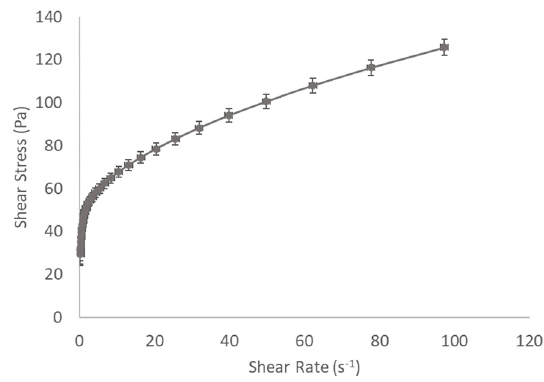
Figure 2. Rheograms of gel formulation prepared from Loureiro subcritical water extract evaluated initially at 25 °C; values were an average of three individual experiments ( n = 3) expressed as mean ± standard deviation.